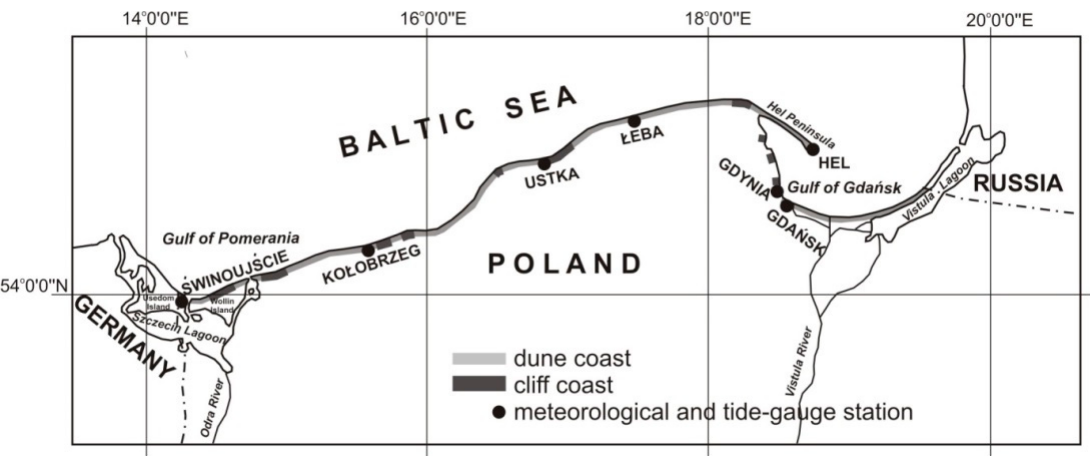
Figure 1. Research area and locations of meteorological and mareographical stations in the coastal zone of the Polish Baltic. zone of the Polish